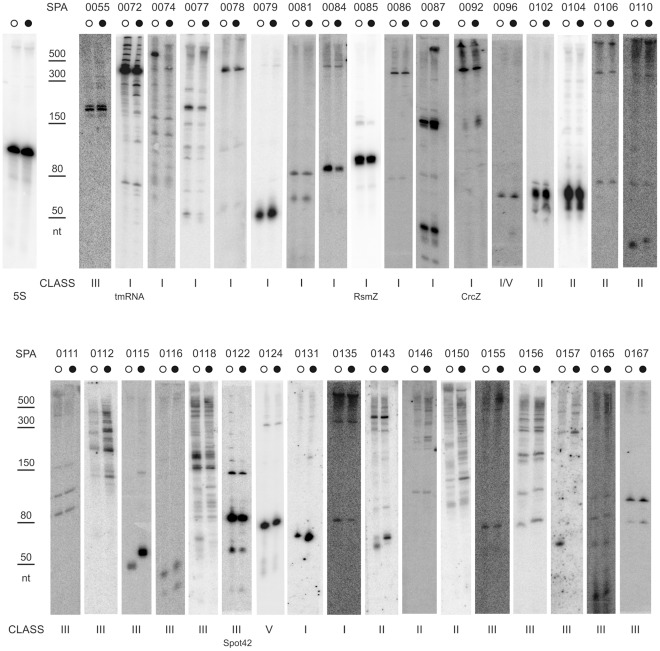
Validation of candidate sRNAs similarly expressed from conserved nstSGR.A selection of conserved nstSGRs listed in Table S2 that were supposed to be similarly expressed between the two strains according to sRNA-Seq data, were inspected by Northern blot. Total RNA was extracted from both PAO1 (○) and PA14 (•) grown in the same conditions as for sRNA-Seq. Equal amounts of RNA (8 µg) from both strains were blotted and probed with radiolabelled oligos or riboprobes (0104, 0112, 0118, 0131, 0143, 0150 and 0157) (Table S1) complementary to nstSGR regions with the highest read coverage. nstSGRs SPA0072, 0085, 0092, and 0122, corresponding to PAO1 loci for the known sRNAs tmRNA, RsmZ, CrcZ, and Spot42, respectively, were included in this analysis as positive controls. 5S RNA served as loading control and molecular weight marker. The ladder of molecular weight markers is indicated on the left of each panel. (nt): nucleotides.